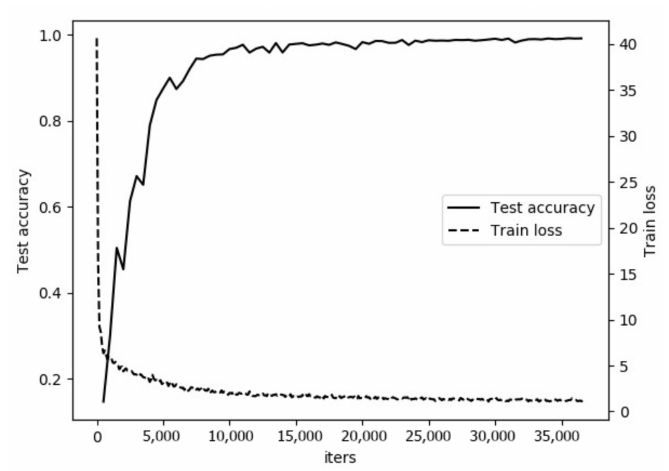
Figure 8. The loss and accuracy curves of models as the number of iterations